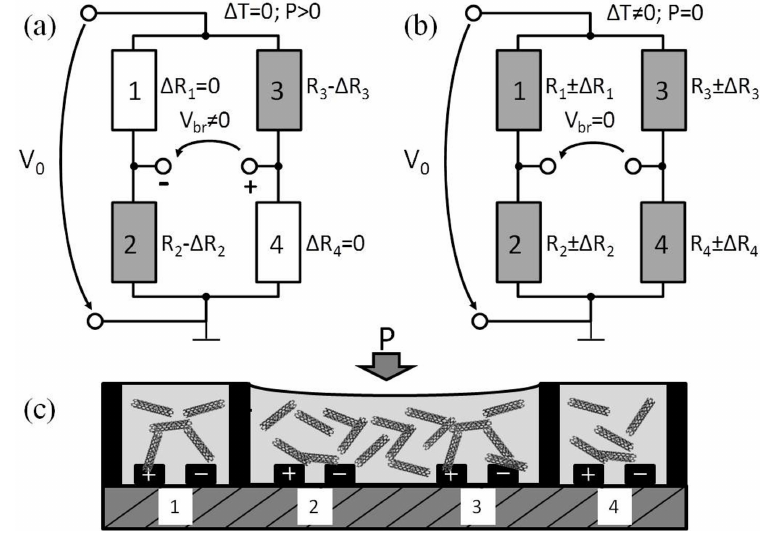
Figure 3. Sensing concept with a half Wheatstone bridge: ( a ) half bridge circuit for the force/pressure sensing; ( b ) full bridge circuit for the temperature compensation; ( c ) four sensing elements on a